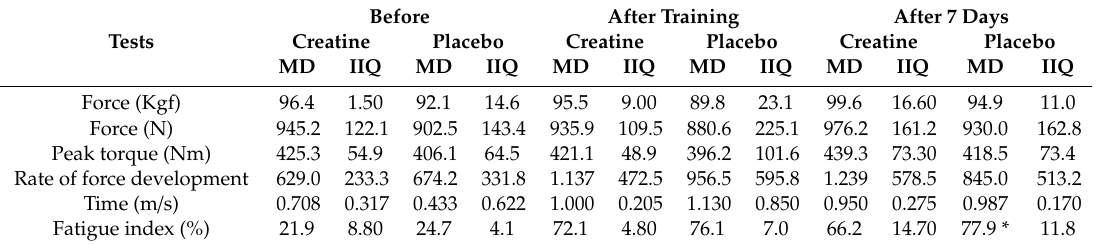
Table 2. Comparison of moments using creatine and using placebo in the di ff erent conditions of the study.